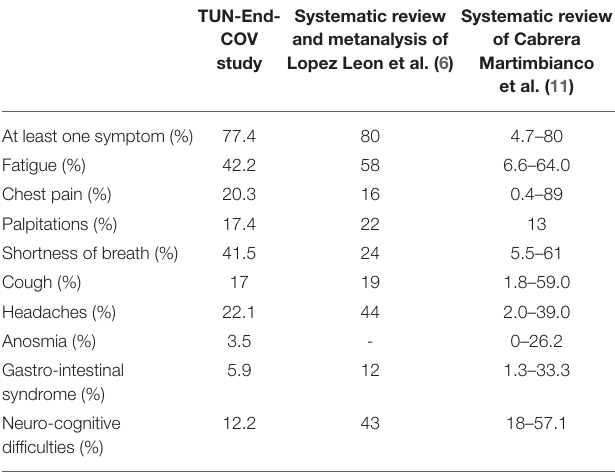
TABLE 6 | Prevalence of long COVID-19 symptoms in the